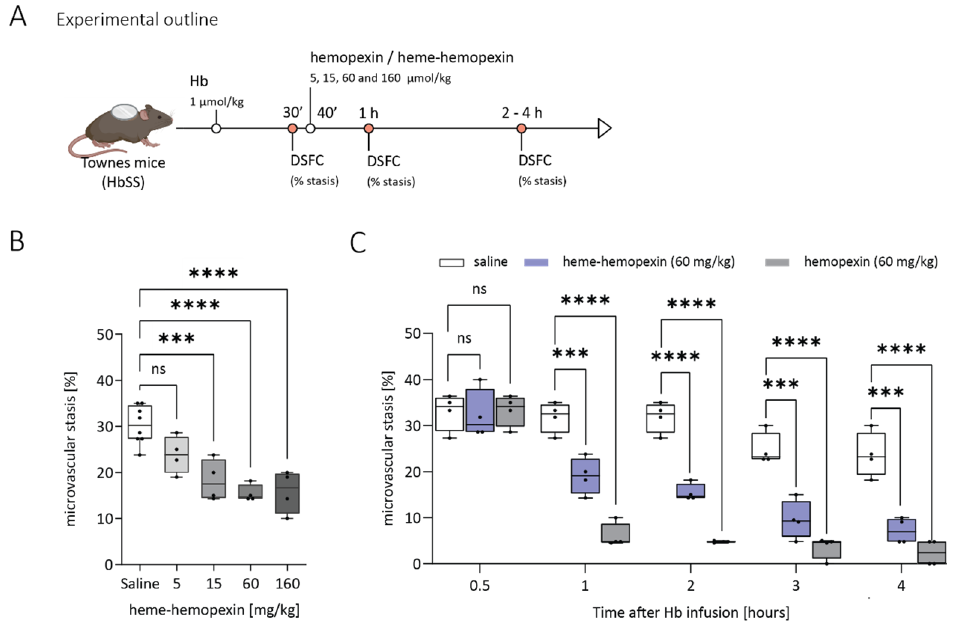
Figure 4. Hemopexin complexed to heme shows a dose-dependent reduction in stasis, but to a lower degree than apo-hemopexin. ( A ) Experimental treatment setup. Dorsal skin-fold chambers (DSFCs) were implanted onto Townes HbSS mice and 20–24 flowing venules were selected in each HbSS mouse at baseline. Microvascular stasis was induced by hemoglobin (Hb, 1 µ mol/kg) and measured in the same venules 30 min after Hb infusion. At 40 min after the hemoglobin challenge, animals were infused with hemopexin, equimolar heme-hemopexin, or saline vehicle. ( B ) Microvascular stasis after HbSS mice ( n = 4 mice/dose) were challenged with Hb and treated with equimolar heme-hemopexin complexes (5, 15, 60, 160 mg/kg hemopexin) or saline was assessed. Data shown from the 2 h time point (after Hb challenge) are presented as Box and whiskers plots representing means ± min to max. ( C ) Microvascular stasis readouts after HbSS mice ( n = 4/dose) were challenged with Hb and treated with hemopexin (60 mg/kg) or heme-hemopexin (60 mg/kg) 40 min after Hb. Stasis was measured at 30 min after Hb (pre-hemopexin), and 1, 2, 3, and 4 h after Hb (post-hemopexin). Data are presented as Box and whiskers plots representing means ± min to max. White boxes: saline; blue boxes: equimolar heme-hemopexin (60 mg/kg); dark grey boxes: hemopexin (60 mg/kg). *** p < 0.001 and **** p < 0.0001 versus SS (saline